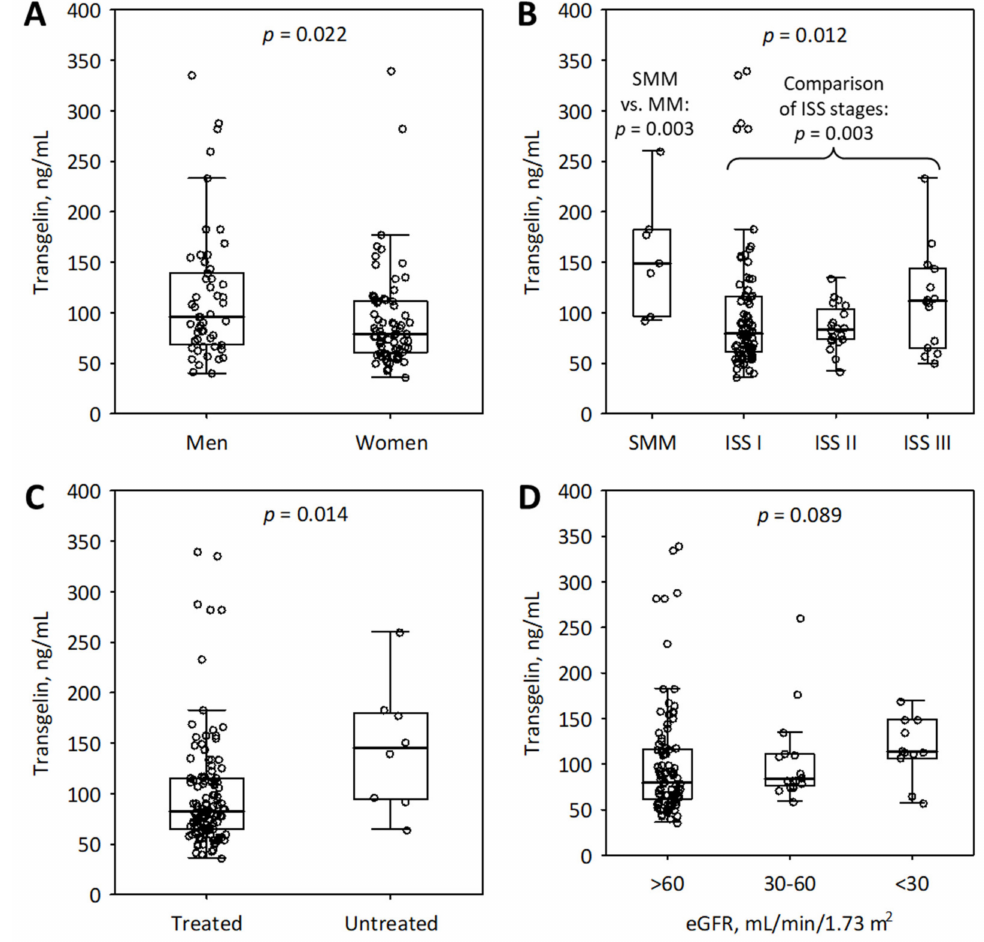
Figure 1. Associations between serum transgelin and sex ( A ), MM stage ( B ), previous treatment ( C ), and eGFR category ( D ) among the studied group of 126 patients with MM. Data are shown as median (central line), interquartile range (box), non-outlier range (whiskers); circles represent raw data. ISS, International Staging System; eGFR, estimated glomerular filtration rate; MM, multiple myeloma; SMM, smoldering